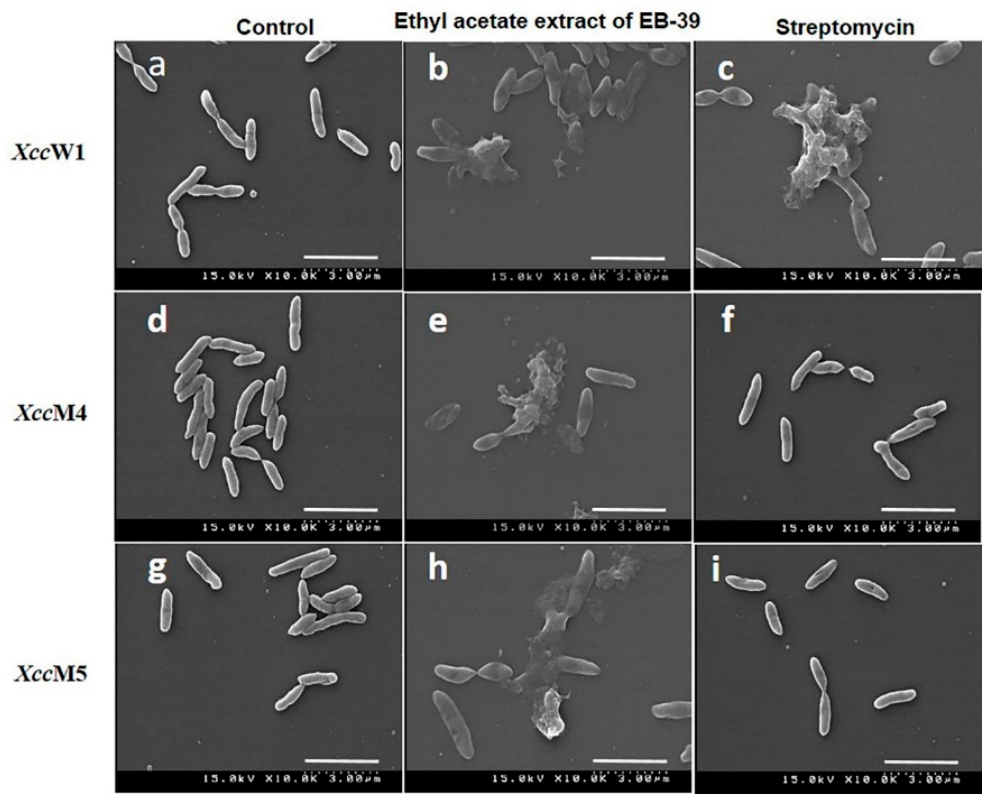
Figure 4. Scanning electron micrographs of Xcc strains treated with methanol as the negative control ( a , d , g ); ethyl acetate extract of EB-39 ( b , e , h ); and streptomycin as the positive control ( c , f , i ). The methanol-treated Xcc strains had a regular, uniform, and smooth surface. The EB-39-treated strains showed disruption, collapse, elongation, and cell lysis. The streptomycin-treated Xcc W1 cells were distorted and eventually lysed; however, the resistant Xcc strains ( Xcc M4 and Xcc M5) had an intact, rod shape with a smooth surface. a–c: Xcc W1 treated with methanol (control), ethyl acetate extract of EB-39, and streptomycin; d–f: Xcc M4 treated with methanol (control), ethyl acetate extract of EB-39, and streptomycin; g–i: Xcc M5 treated with methanol (control), ethyl acetate extract of EB-39, and streptomycin. Scale bar: 3 µm.